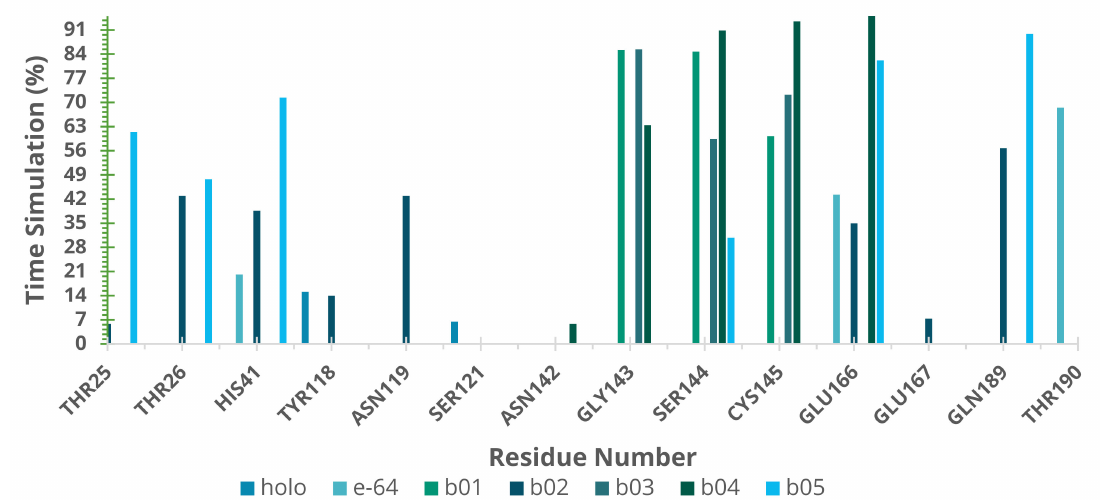
Figure 4. Hydrogen bond stability in SARS-CoV-2 Mpro complexes as calculated by HbMap2Grace after 100 ns of molecular dynamics